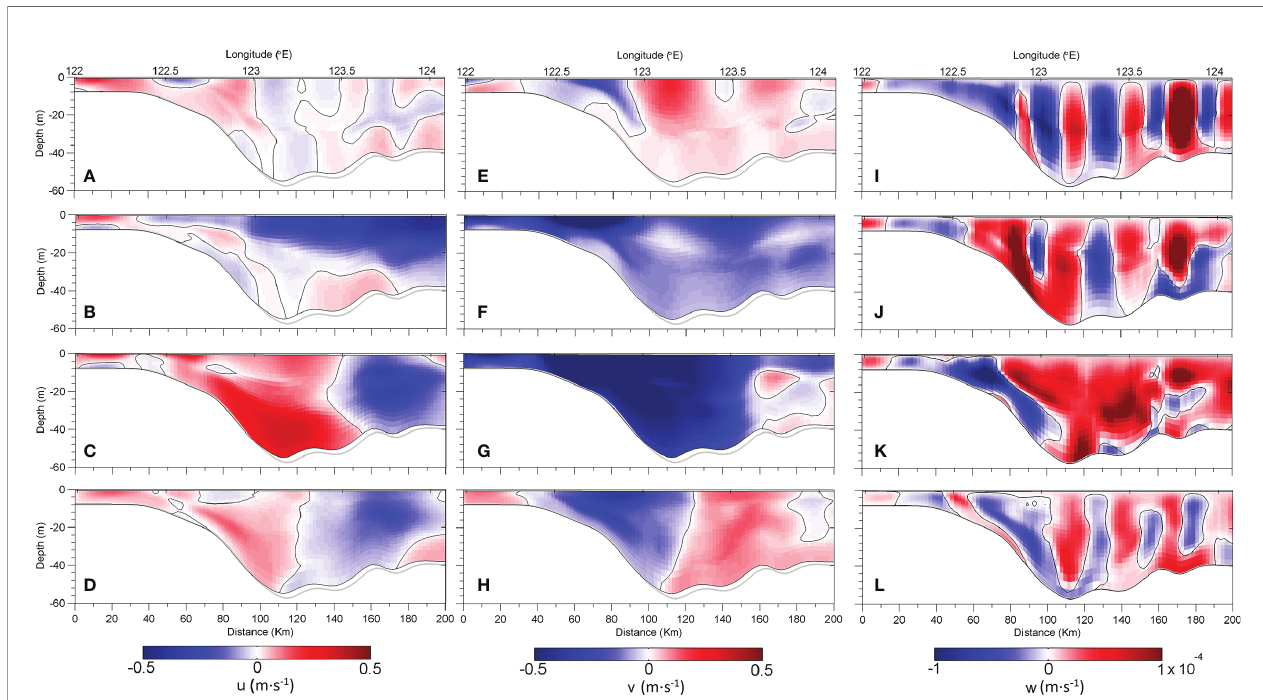
FIGURE 8 | The modeled daily-mean zonal velocity ( u ; positive eastward) at the 31°N transect on August 22 (A) , 25 (B) , 26 (C) , and 28 (D) , 2020. The modeled daily-mean meridional velocity ( v ; positive northward) at the 31°N transect on August 22 (E) , 25 (F) , 26 (G) , and 28 (H) , 2020. The modeled daily-mean vertical velocity ( w ; positive upward) at the 31°N transect on August 22 (I) , 25 (J) , 26 (K) , and 28 (L) ,